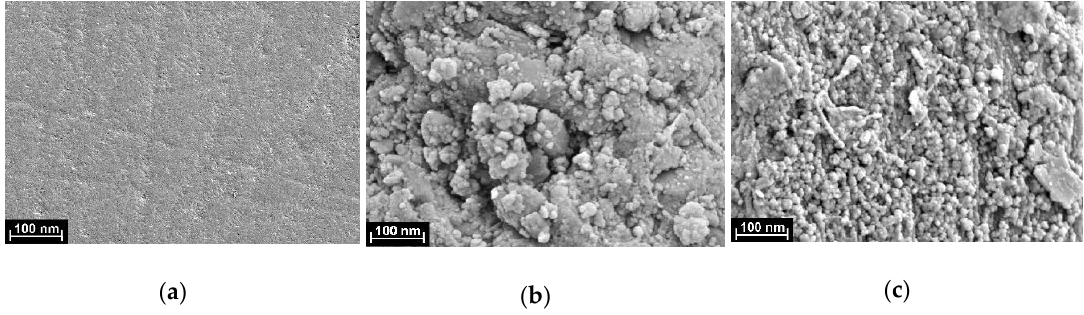
Figure 3. SEM microimages of bare glassy carbon electrode ( a ), of the copolymer of Azure B and proflavine prior to ( b ) and after DNA adsorption ( c ).